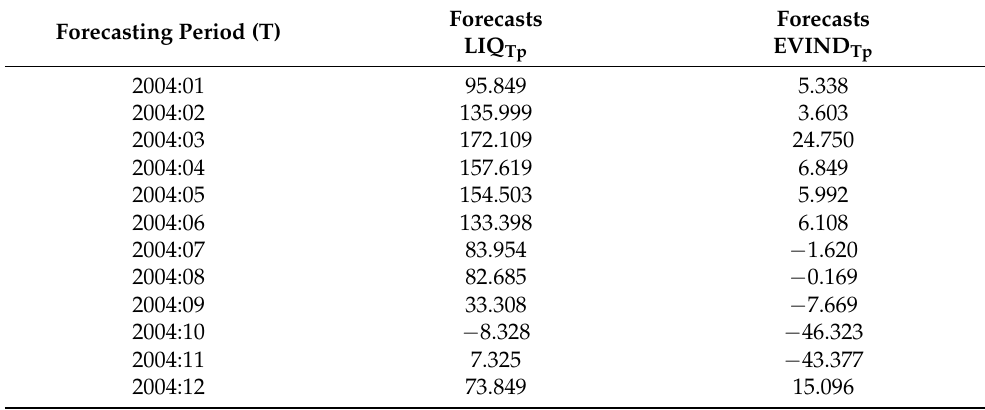
Table 8. Convergent monthly forecasts of the company’s financial liquidity (LIQ Tp ) and debt recovery efficiency (EVIND Tp ) for the year